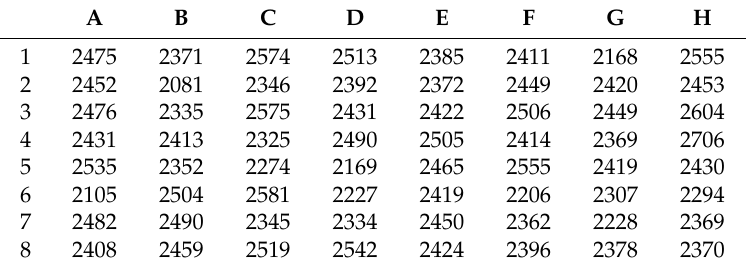
Table A2. Measured values of CO 2 concentration distribution in Experiment A1 (ppm).